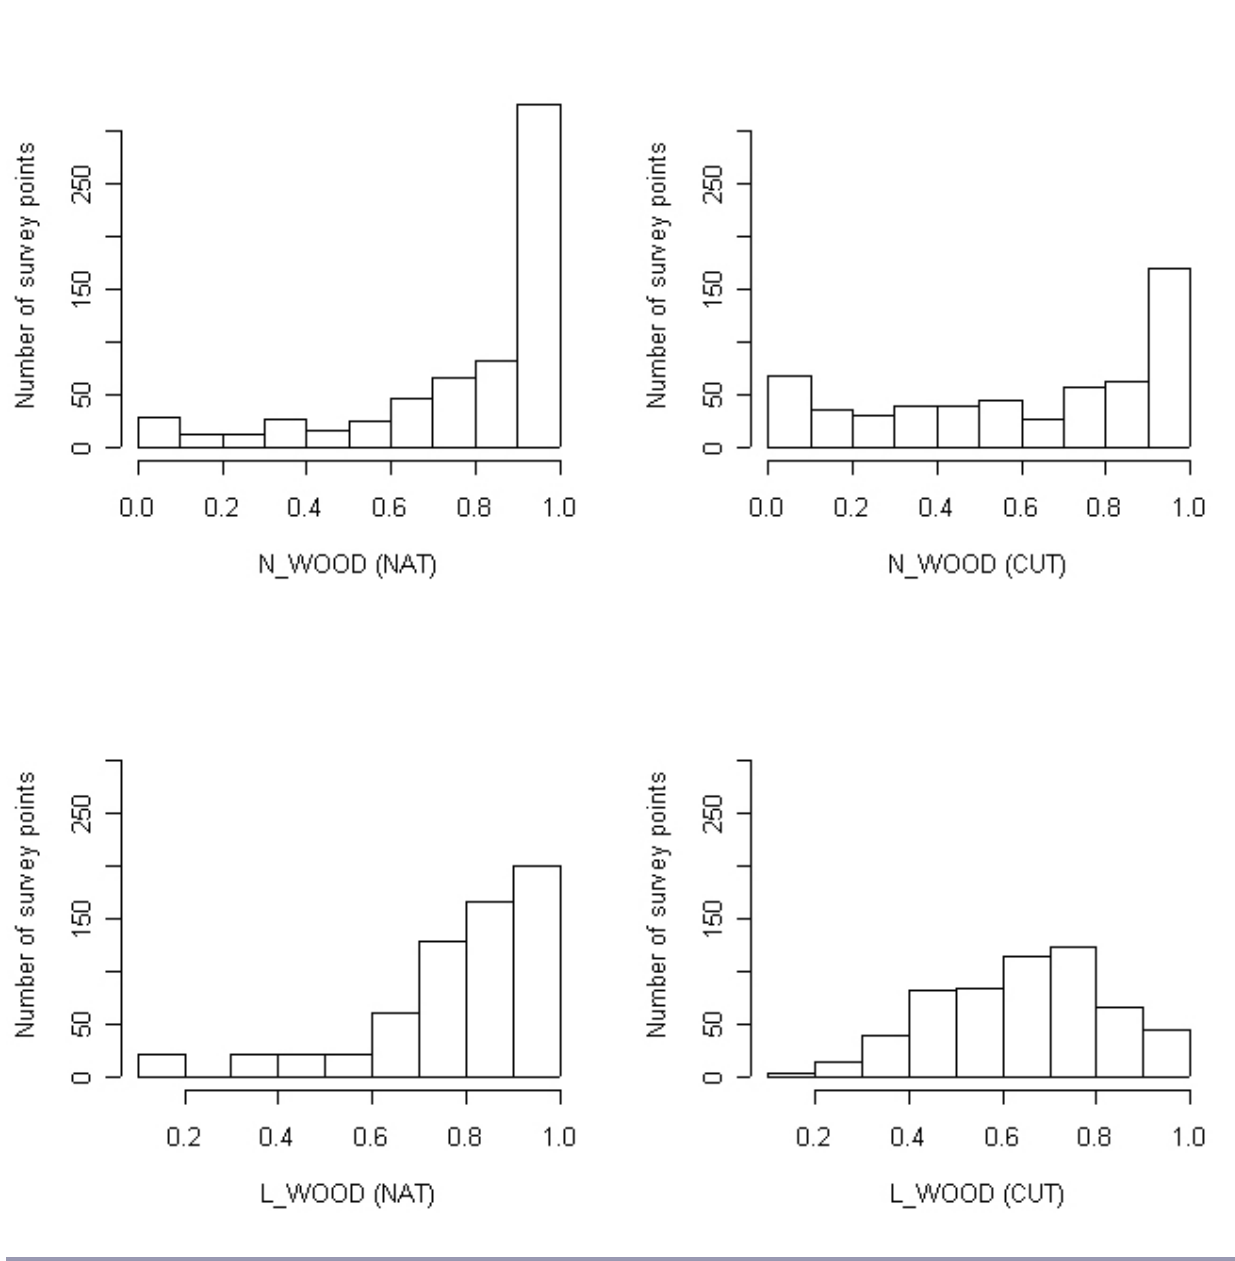
Fig. 1. The frequency distribution of neighborhood woodland cover (N_WOOD) and landscape woodland cover (L_WOOD) in harvested (CUT) and unharvested (NAT)